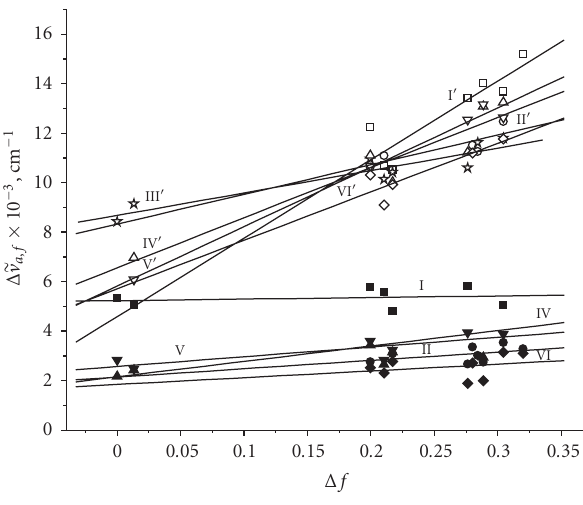
Figure 4: The dependence of the fluorescence Stokes’ shift for LE and CT bands of the compounds I–VI on the solvent polarity pa- ); IV, IV (cid:5) ( (cid:7) ); V, rameter Δ f at 293 K: I, I (cid:5) ( (cid:2) ); II, II (cid:5) ( (cid:6) ); III (cid:5) ( (cid:0) V (cid:5) ( (cid:8) ); VI, VI (cid:5) ( ♦ ). The filled symbols stands for LE and the hollow symbols stands for corresponding CT